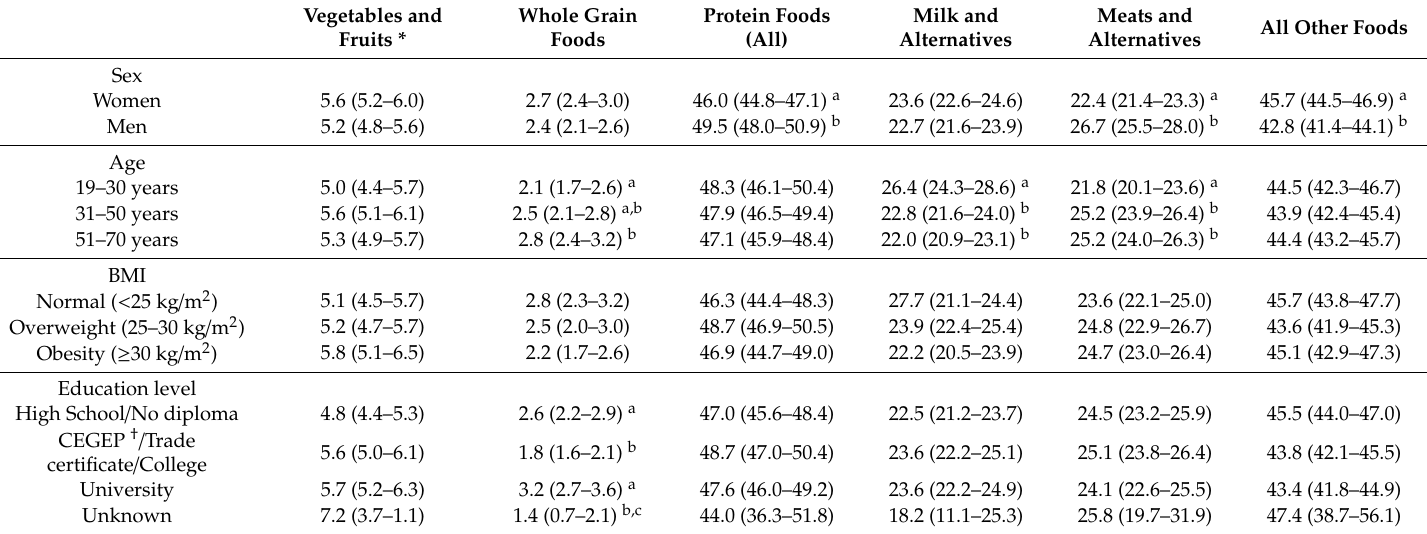
Table 2. Contribution of each 2019 Canada’s Food Guide categories to total SFA intake according to sex, age, body mass index (BMI), and education level in Canadian adults (19–70 years